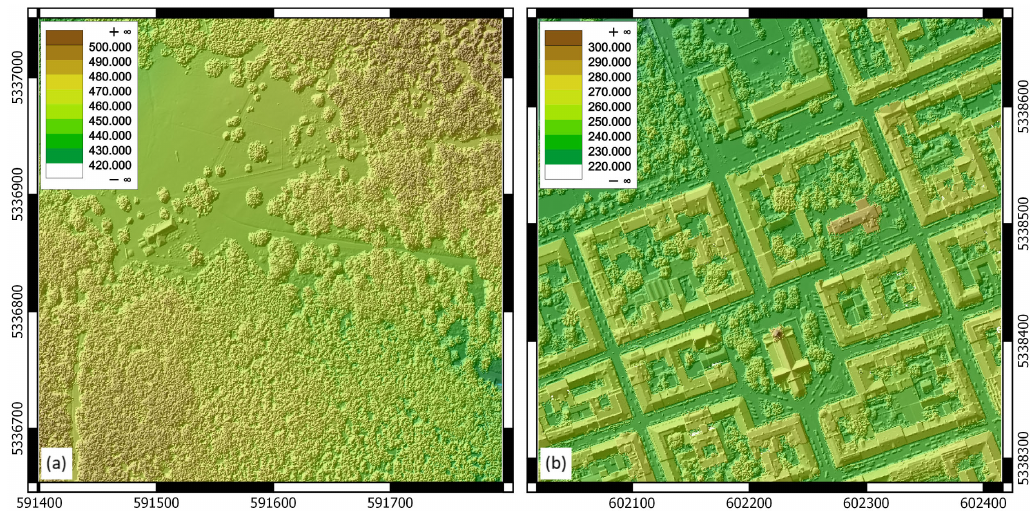
Figure 2. Flight block Vienna; (a) Single Photon LiDAR, (b) waveform LiDAR, red rectangles: detailed test areas (cf. Figure 3)